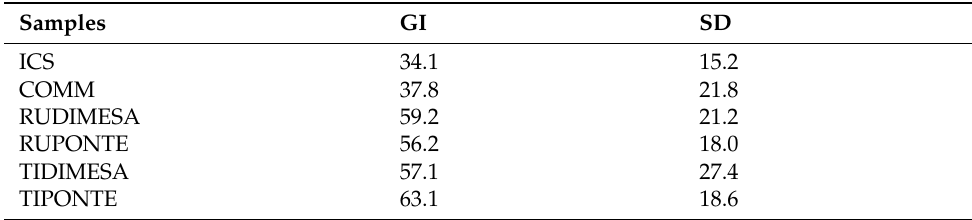
Table 4. Glycemic Index evaluated for the six pasta